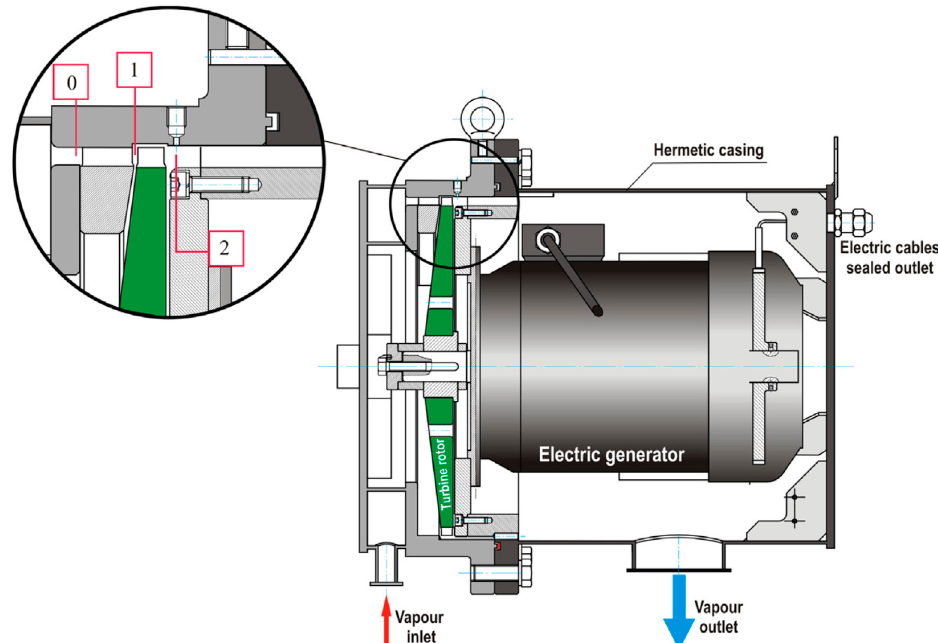
Figure 7. View of the ORC turbogenerator.